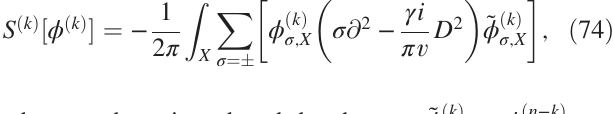
ffiffiffiffiffiffiffiffi p 2 =n e i 2 π lk=n ∈ C . The Gaussian part of the